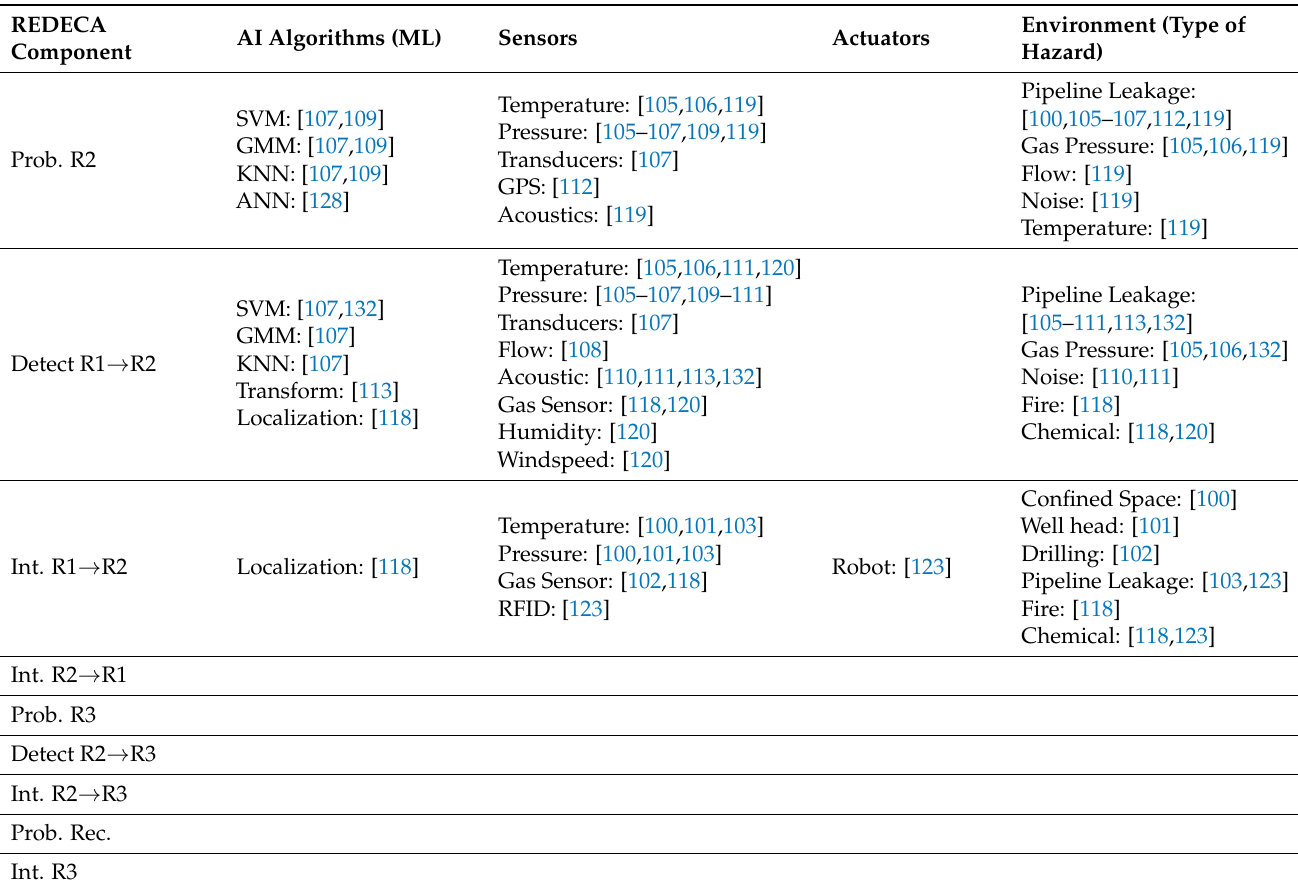
Table 5. Oil and Gas AI/OSH algorithm, sensor and actuator research organized by the REDECA framework. Major technologies described by each paper is mentioned and linked to the relevant papers [99–133]. Summary of each paper is found in Appendix